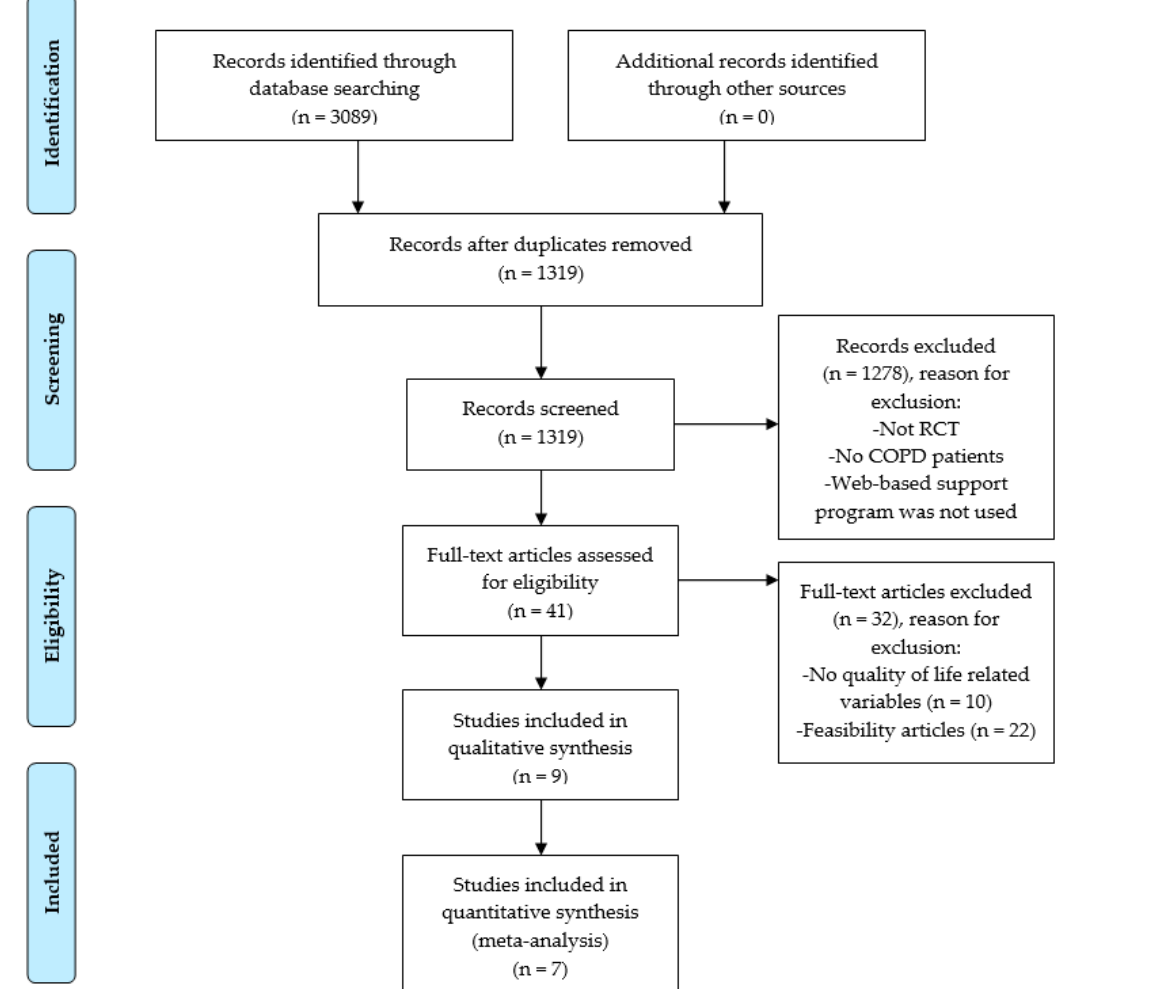
Figure 1. PRISMA flow chart of the literature screening process and results.